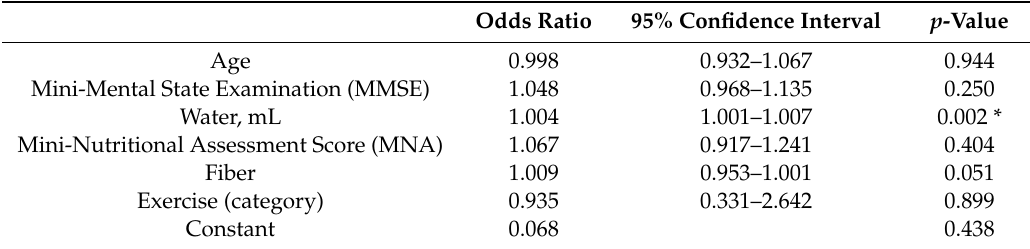
Table 4. Binary logistic regression models for constipation in patients with